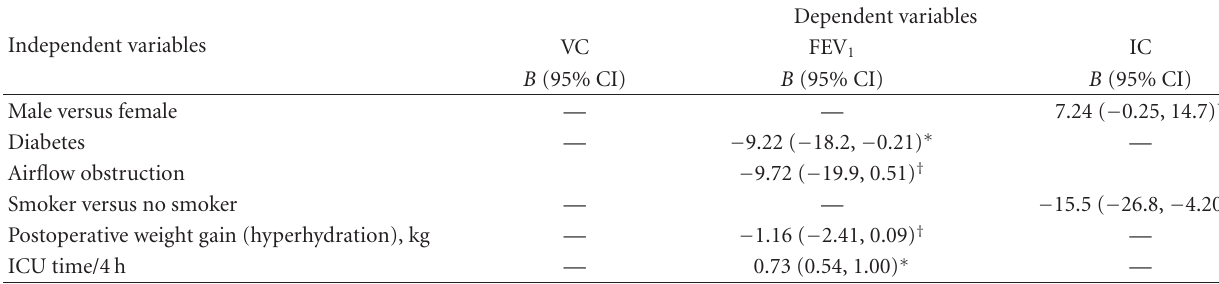
Figure 2: (a) Mean VC, 95% CI, postoperatively in percent of predictive values for patients in di ff erent age groups ( n = 107; 37–60 years, n = 20; 61–70 years, n = 46; 71–80 years, n = 35; 81–86 years, n = 6) ; P = 0 . 04 between all groups. (b) Mean IC, 95% CI, postoperatively in percent of predictive values for di ff erent genders and BMI. ( n = 107, female n = 21, male n = 86, BMI ≤ 25 n = 42, BMI > 25 n = 65). Table 4: The variables associated with decrease in postoperative lung volumes (in % of the preoperative value), ( n = 107). Univariate